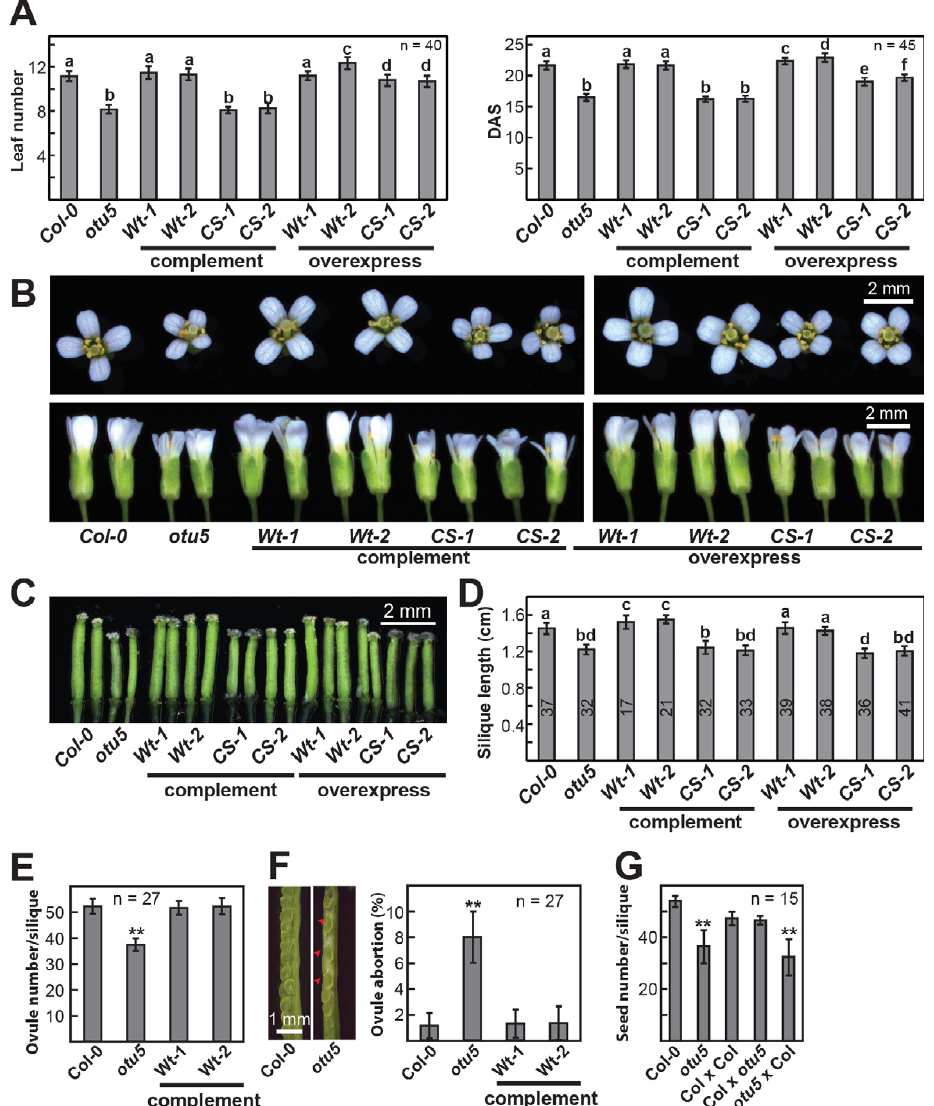
Figure 2. Reproductive growth phenotypes of otu5-1 plants. ( A ) Flowering times measured either by rosette leaf number (left) or DAS (right) at bolting for Col-0 and otu5-1 plants, and various complemented and overexpressed lines grown under long-day conditions. ( B ) Top or side view of representative flowers. ( C ) Representative gynoecia/pistils of mature flowers. ( D ) Averaged lengths of matured siliques (numbers of siliques averaged are indicated). ( E ) Averaged ovule number of each silique. ( F ) A significant proportion of aborted ovules (red arrows) was observed in the mature siliques of otu5-1 . Left, representative dissected siliques from Col-0 and otu5-1 plants. Right, ovule abortion rate. ( G ) Seed numbers for each silique for selfed Col-0 and otu5-1 plants and for control (Col × Col) and reciprocal crosses between Col-0 and otu5-1 plants. Different letters denote significant differences by pairwise comparison using Student’s t -test. ** p < 0.01, otu5-1 was compared with Col-0, or selfed otu5-1 plants, control, and reciprocal crossed plants were compared with selfed Col-0 plants using Student’s t -test. Sample sizes are indicated ( n ). Error bars indicate standard devia- tions.